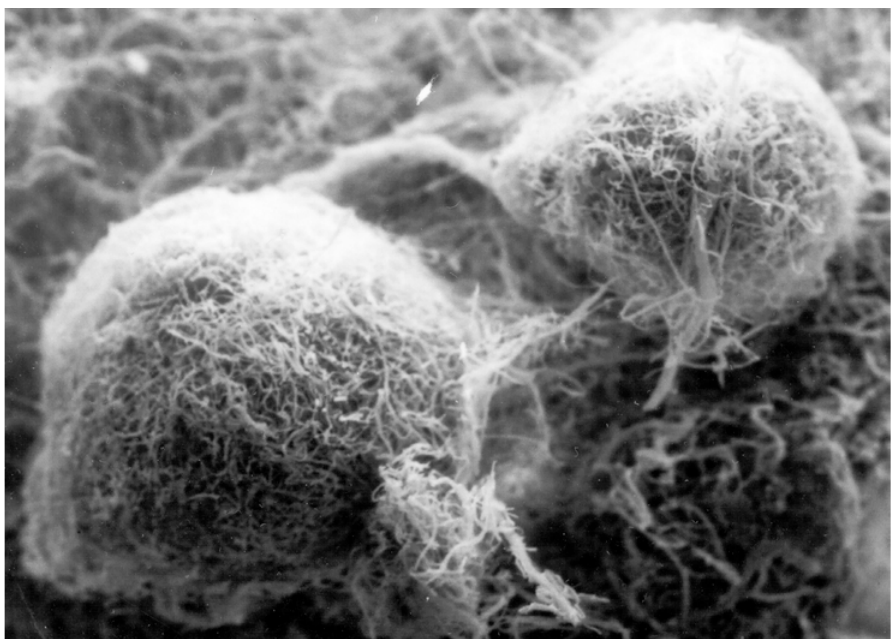
Fig. 1. Pycnidia of Phoma capitulum (SEM x 250). Phot. M. Wróbel.